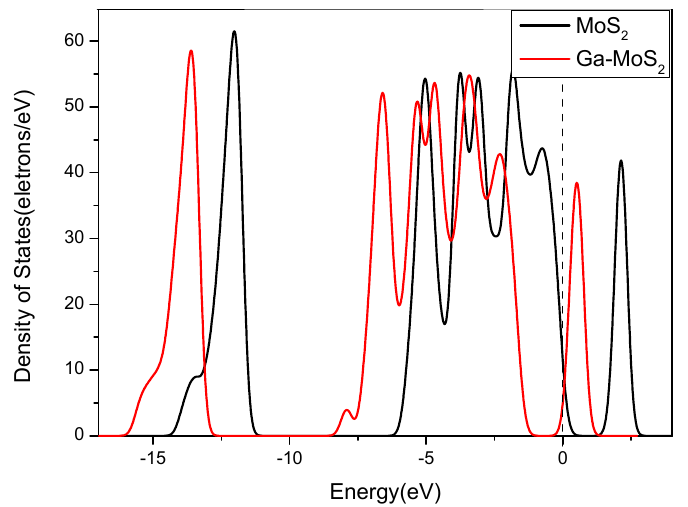
Figure 4. The density of states (DOS) curves comparison before and after doping. The dotted lines are Fermi level.